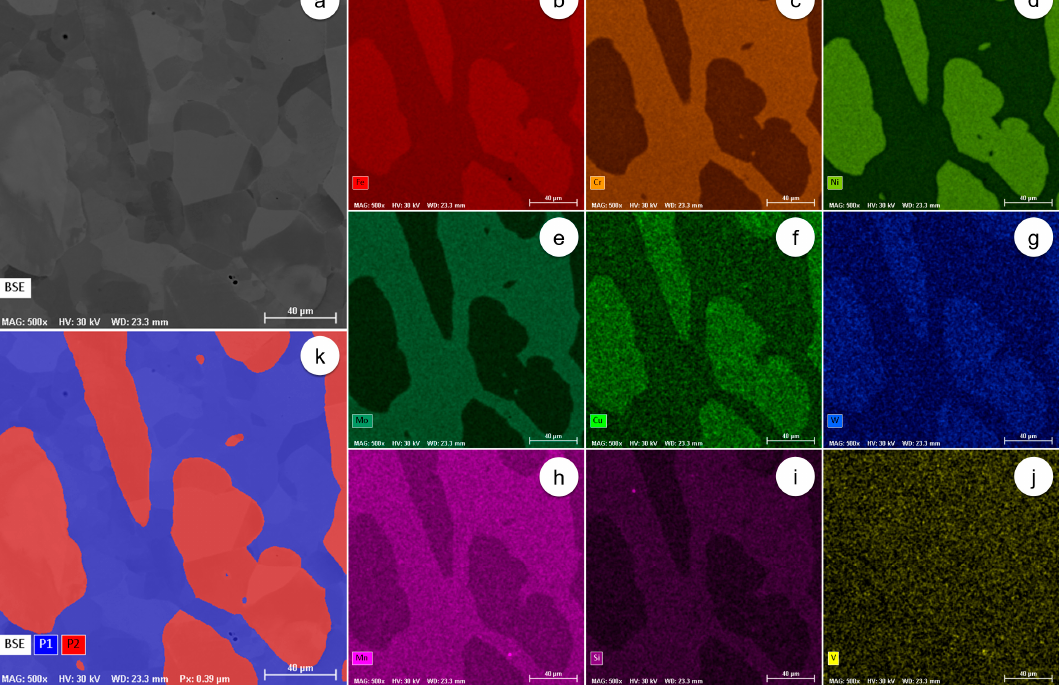
Figure 2. The representative distribution maps of alloying elements and phases in the as-received UNS S32750 SDSS alloy: ( a ) the microstructure of the analysed field; ( b ) the SEM-EDS distribution of Fe; ( c ) the SEM-EDS distribution of Cr; ( d ) the SEM-EDS distribution of Ni; ( e ) the SEM-EDS distribution of Mo; ( f ) the SEM-EDS distribution of Cu; ( g ) the SEM-EDS distribution of W; ( h ) the SEM-EDS distribution of Mn; ( i ) the SEM-EDS distribution of Si; ( j ) the SEM-EDS distribution of V; ( k ) the computed distribution of phases in the microstructure of the analysed field.